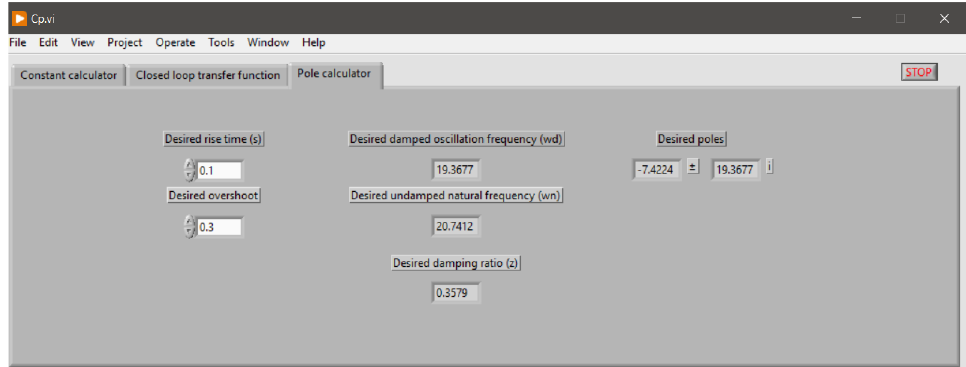
Figure 16. Graphical interface for calculating the desired poles for the use of the locus of roots.